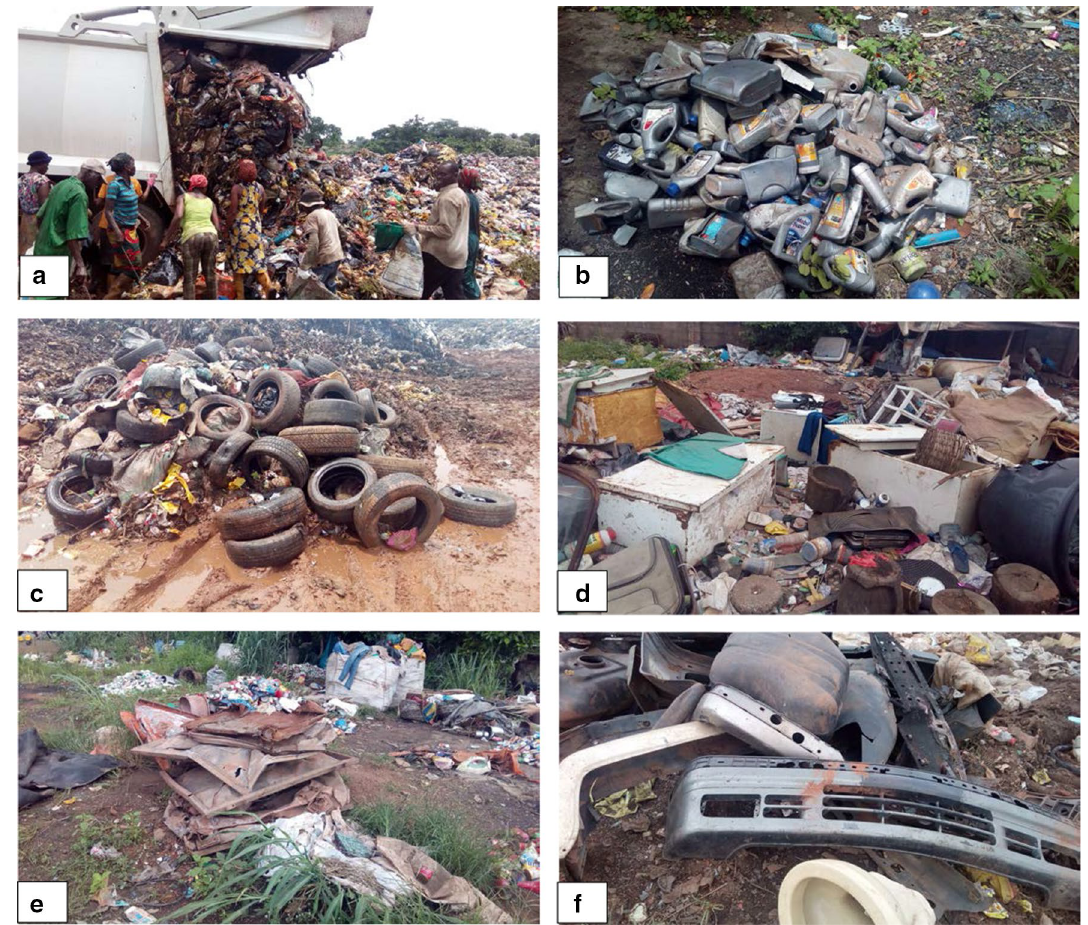
Fig. 7 Waste dump at the Enugu dumpsite, a Unsorted, b engine oil cans, c used car tyres, d electrical and electronic appliances e car spare parts